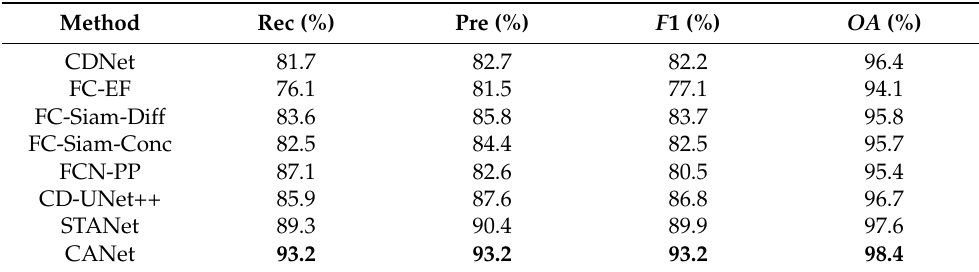
Table 3. Comparison of CDD dataset results (the best performance is emphasized in